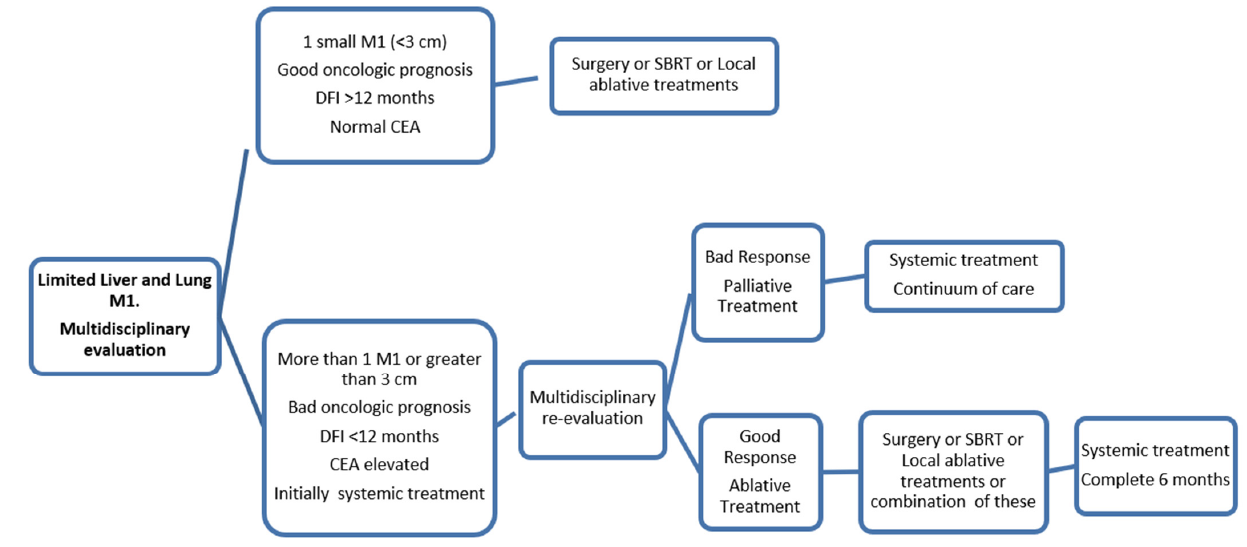
Figure 3. Treatment algorithm in limited liver and lung CRC metastases.